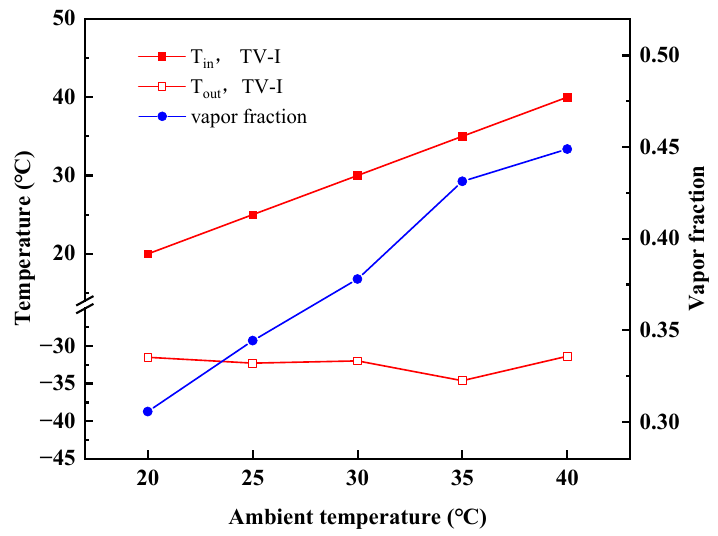
Figure 9. Parameters on the first throttle valve at different ambient temperatures.